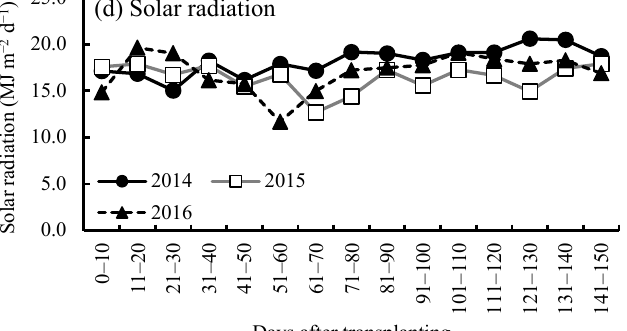
Figure 1. Changes in the daily mean ( a ), maximum ( b ), and minimum ( c ) temperatures and in the daily average radiation ( d ) during the 2014, 2015, 2016, and 2017 seasons. Values on the Y-axis show the temperatures (°C), while X-axis indicates the days after transplantation. Each point represents the mean value of 10 days. Solar radiation in 2017 was not available.